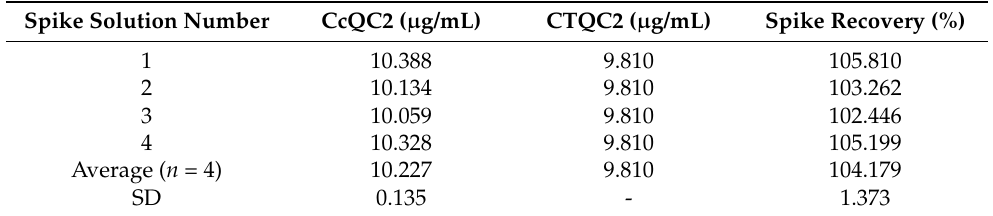
Table 3. Spike recovery % calculation, after four injections with 10 µ g/mL usnic acid QC2 solution (spike